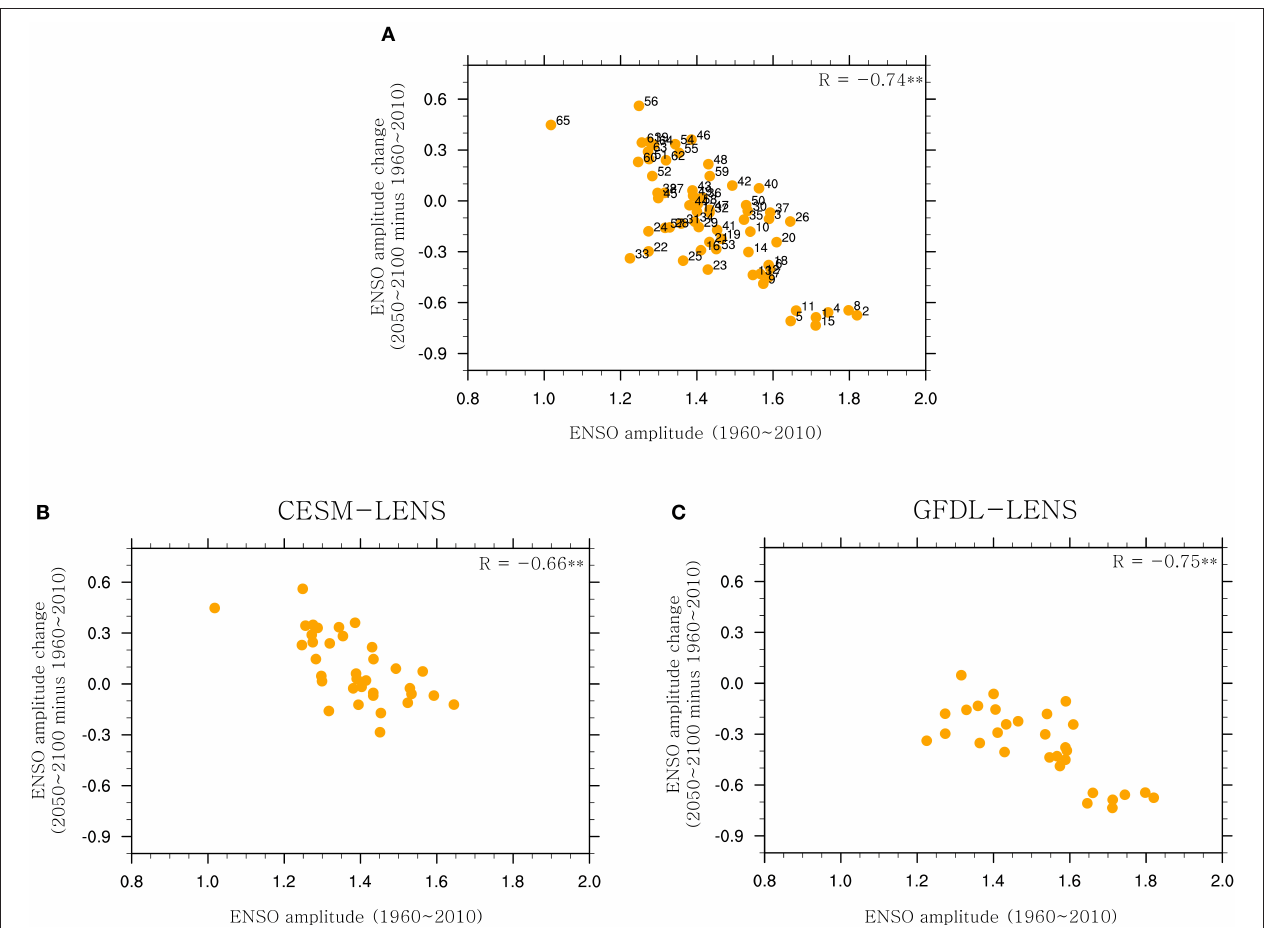
FIGURE 7 | ENSO amplitude in the present climate vs. ENSO amplitude change from the present climate (1960–2010) to the future climate (2050–2100) in 65-ensemble members. Note that numbers in (A) denote the 65-ensemble members ranked by the intensity of ICV from the strongest to the weakest during the present climate (see Figure 2 ). Unit is ◦ C. (B,C) are the same as in (A) except the CESM-LENS and GFDL-LENS, respectively. The values inside (A–C) denote the correlation coefficients between two corresponding